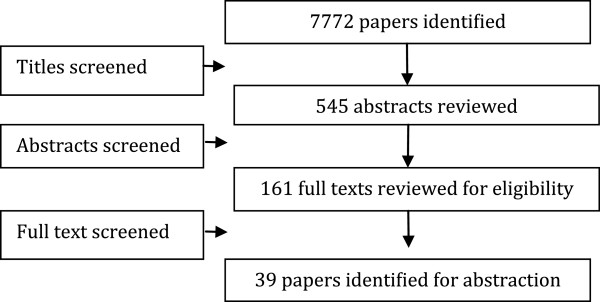
Search flow diagram.